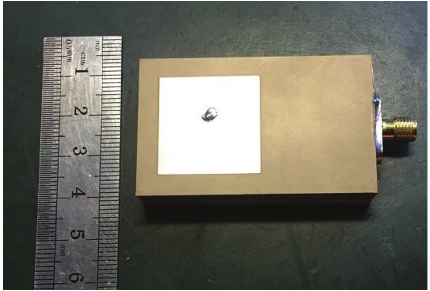
Figure 8: Designed antenna.